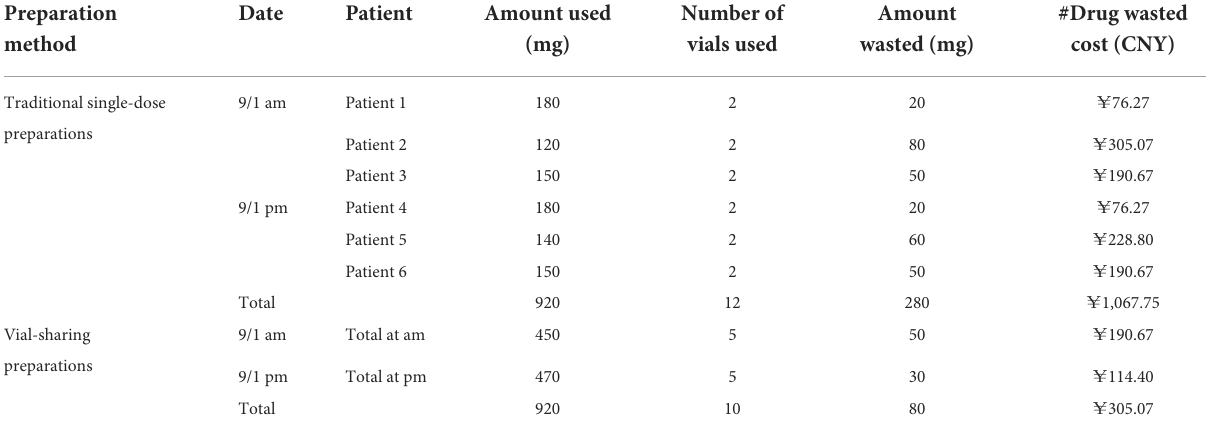
TABLE 2 Example of total *Oxaliplatin waste costs for traditional single-dose preparation and vial-sharing preparation options. Preparation